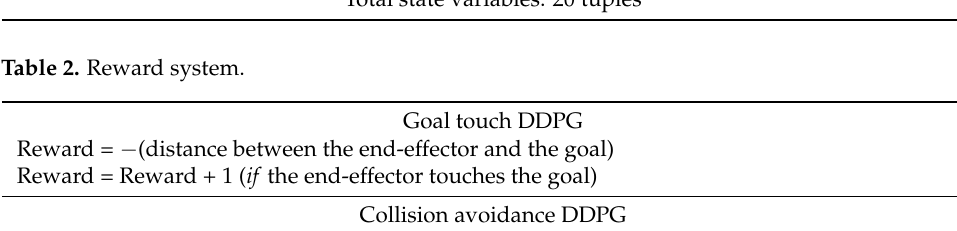
Reward = − (distance between the end-effector and the goal) Reward = Reward + 1 ( if the end-effector touches the goal) Collision avoidance DDPG Reward = +(sum of distances between each joint and the closest nearby obstacle × r bf ) Reward = Reward − 1 ( if a joint touch the closest nearby